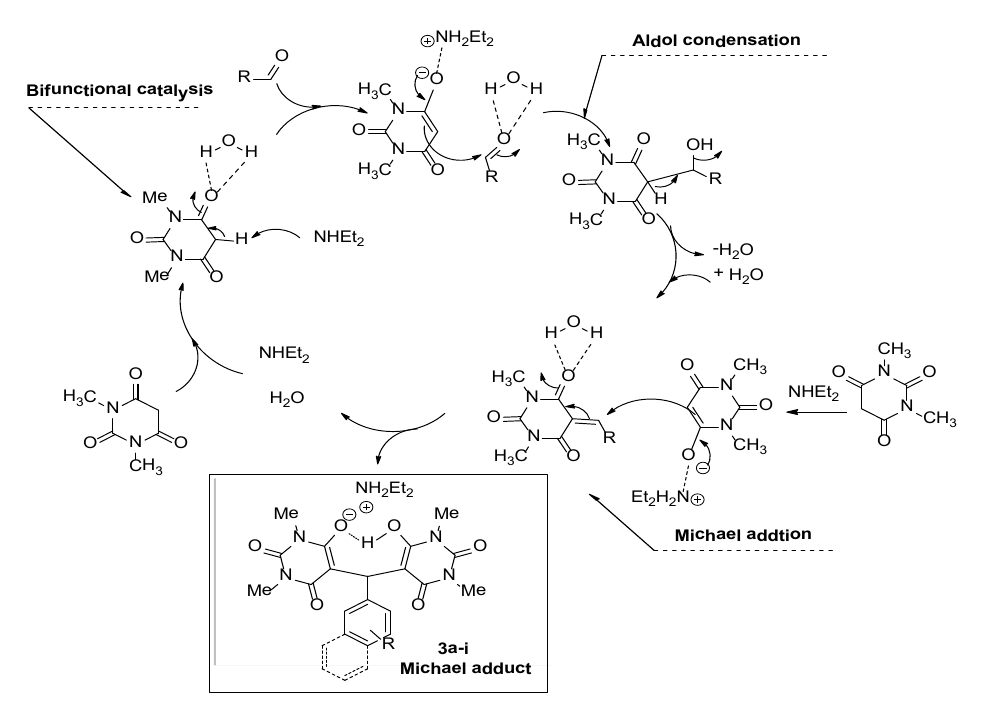
Figure 3. A possible mechanistic